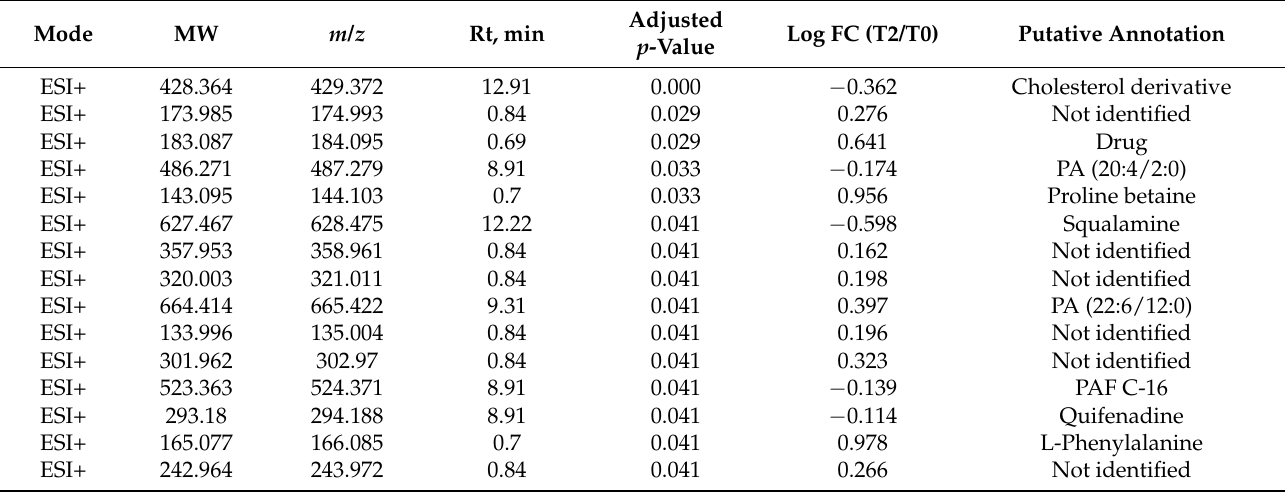
Table 2. Metabolites identified by UHPLC-ESI-QTOF-MS that appeared significantly affected by 12 week treatment with PCSK9